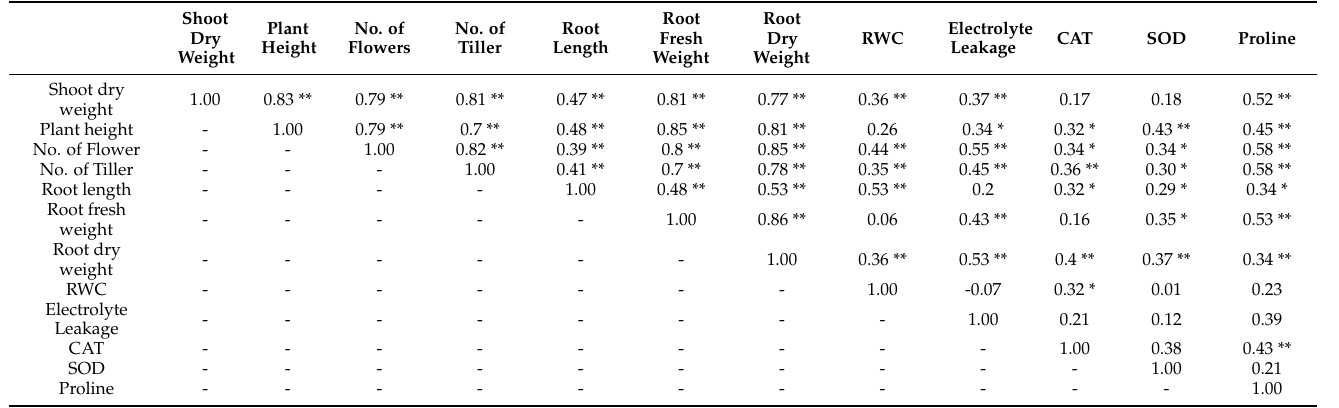
Table 6. Correlation among different traits of two alfalfa genotypes as affected by three salt levels (control “Hoagland”, 6, and 10 dSm − 1 ) and three treatments of nano-fertilizers (K 2 SO 4 , ZnO, SiO 2